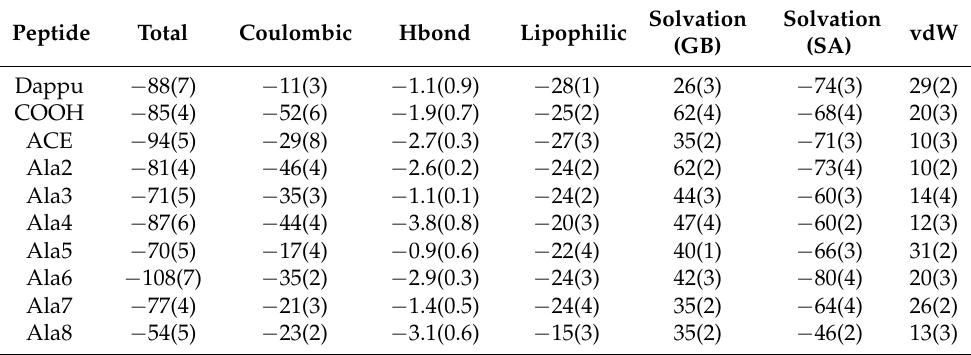
Table 2. Selected energy contributions to ∆ G binding of a series of mutated Dappu-RPCH binding to Dappu-RPCH R. Energy is in kcal mol − 1 with standard deviations in brackets. Results were calculated using MMGBSA on a trajectory from a 50 ns MD simulation of different peptides bound to Dappu-RPCH R in a hydrated POPC